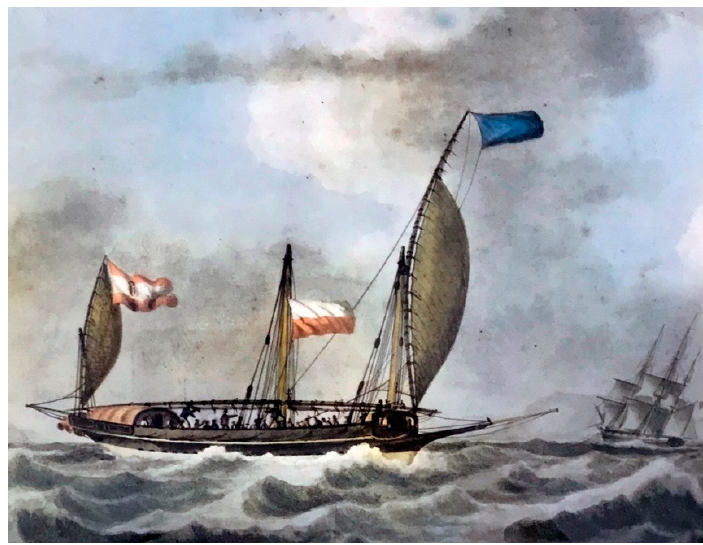
Figure 1. Antoine Roux’s Felouque espagnole , Spanish shebek, from 1830. Public domain.